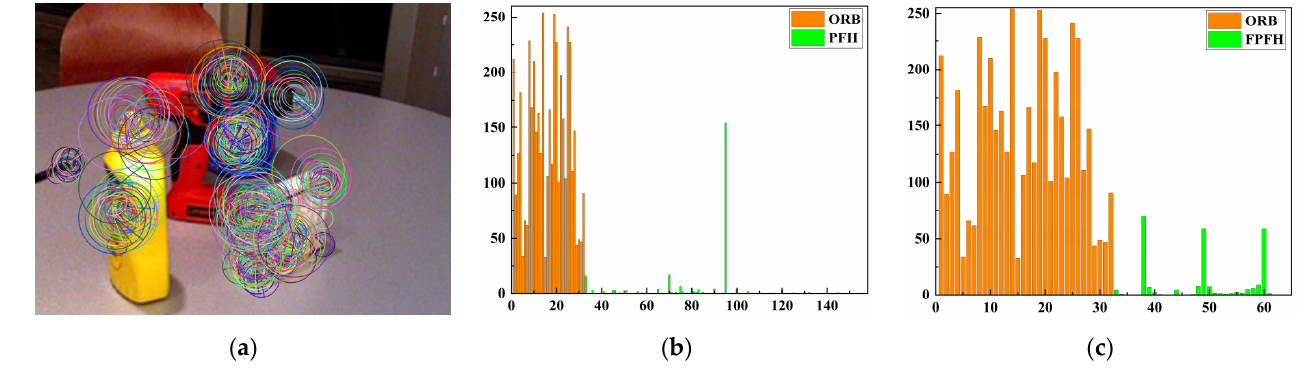
Figure 11. Extracted ORB feature points and feature histograms of ORBPFH and ORBFPFH at pixel ( 374, 373 ) ; the norm of PFH or FPFH here is 256. ( a ) Extracted ORB feature points; ( b ) ORBPFH feature histogram; ( c ) ORBFPFH feature histogram.